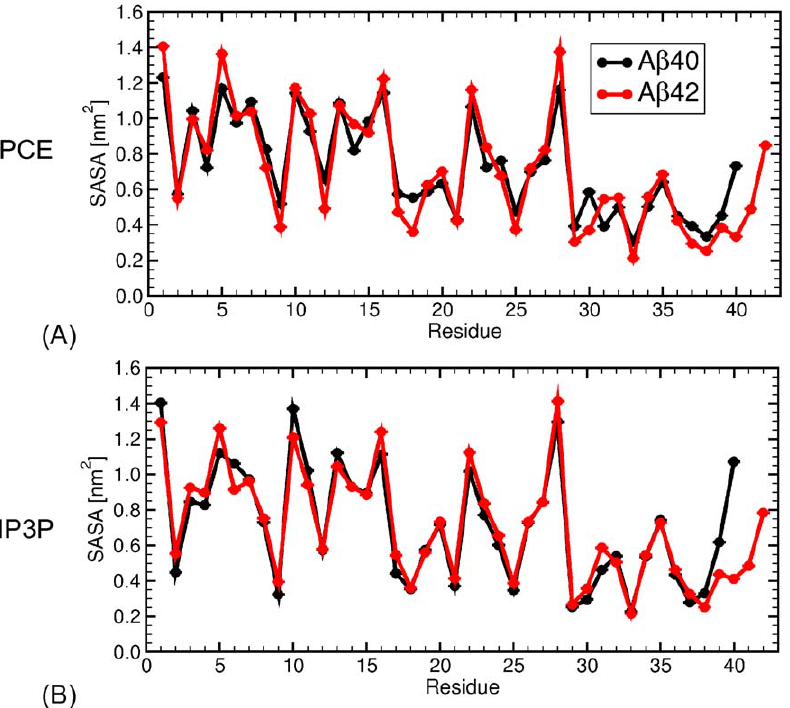
Figure 6. The average SASA per amino acid in A b dimers. The thick black and red curves correspond to SASA for all-atom A b 1 { 40 and A b 1 { 42 dimers obtained by MD using the (A) SPCE and (B) TIP3P water model. The error bars are SEM values.